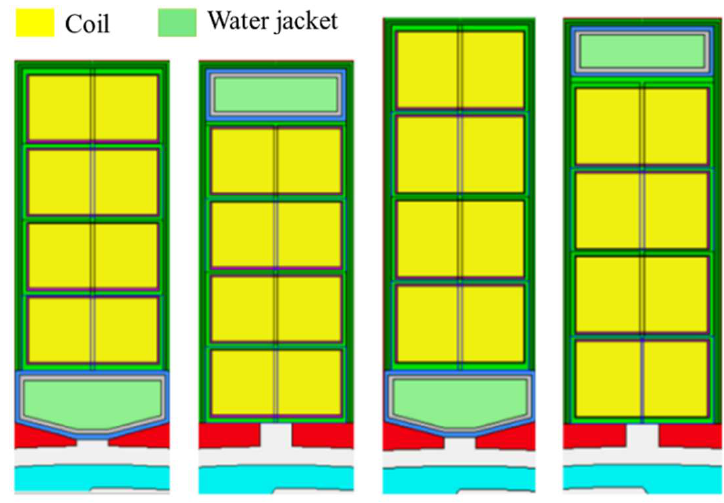
Figure 12. Four different slot designs with water jackets [36].